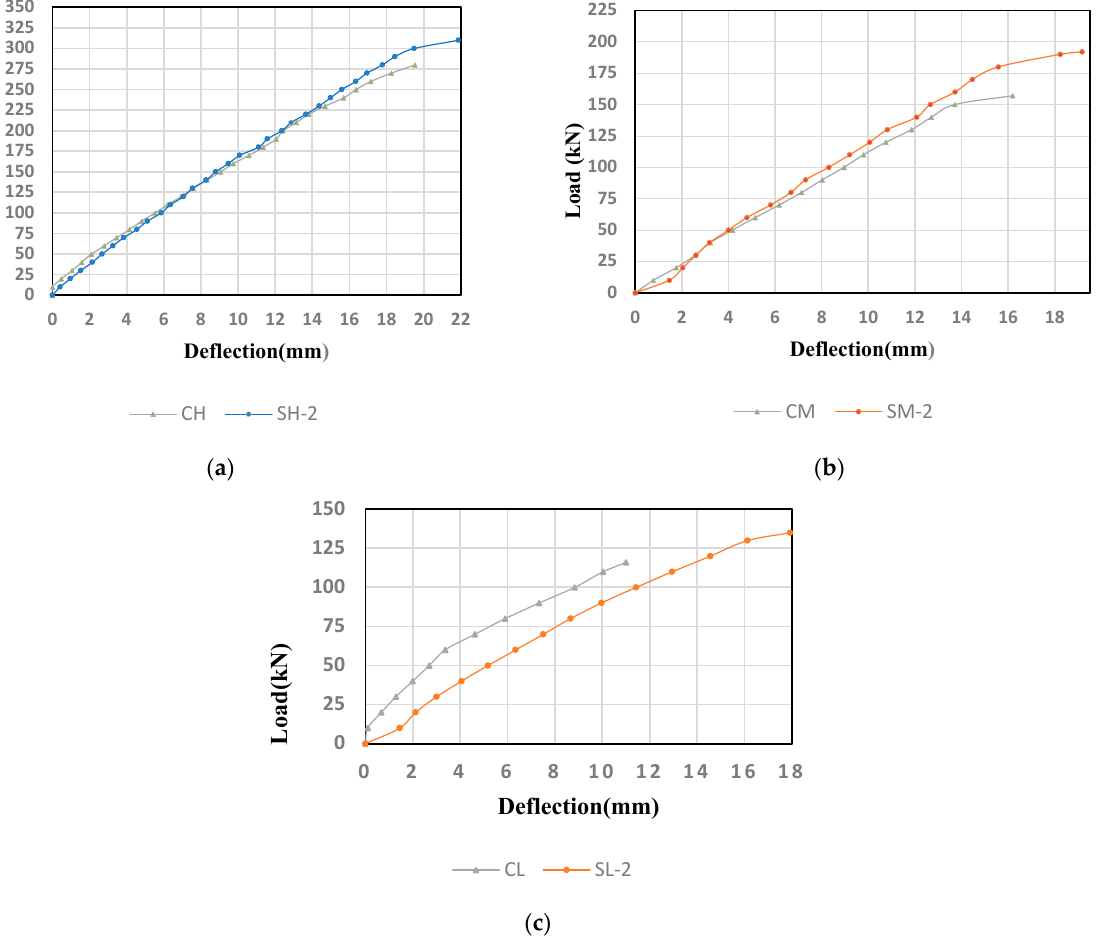
Figure 11. Load–deflection curve for: ( a ) CH and SH-2, ( b ) CM and SM-2, ( c ) CL and SL-2.